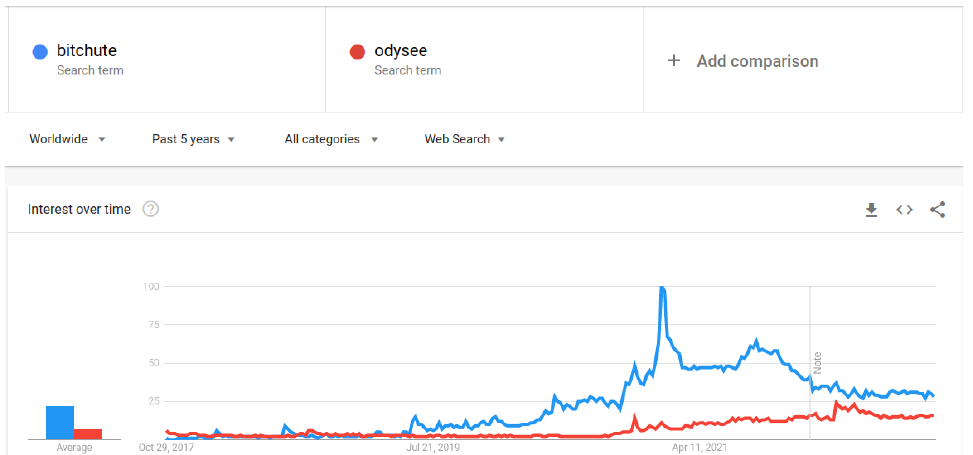
Figure 2. Google Trends analysis on BitChute and Odysee search